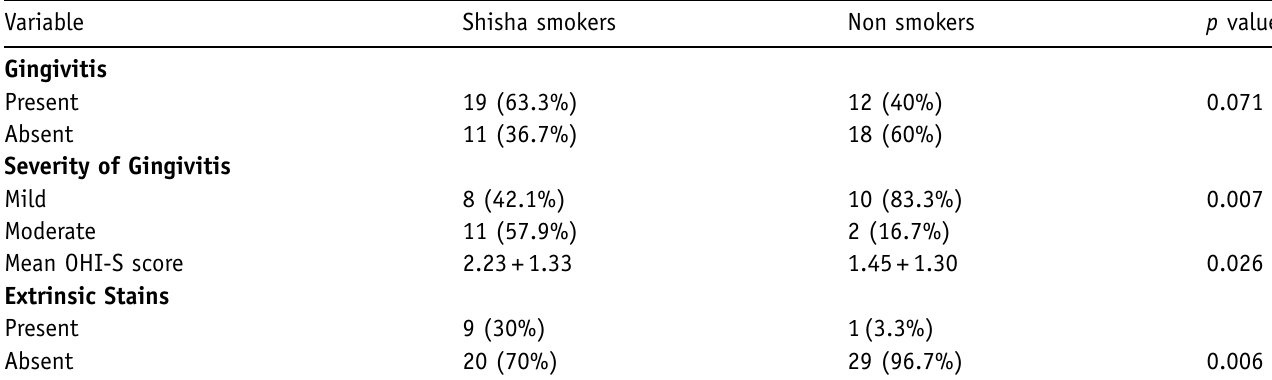
Table II. Comparison of Gingival and Oral Hygiene scores between shisha smokers and non-smokers. Variable